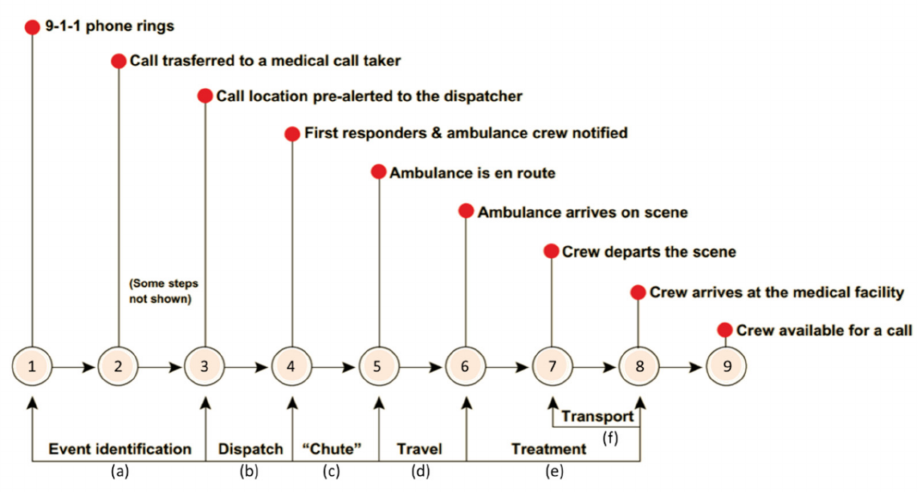
Figure 1. Events and stages of EMS mission time